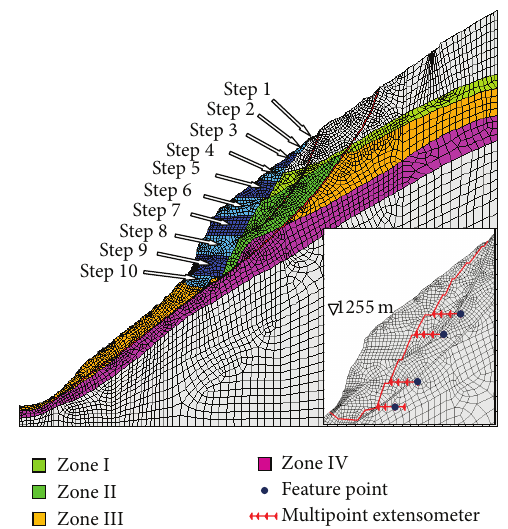
Figure 10: Monitoring points and excavation steps in the